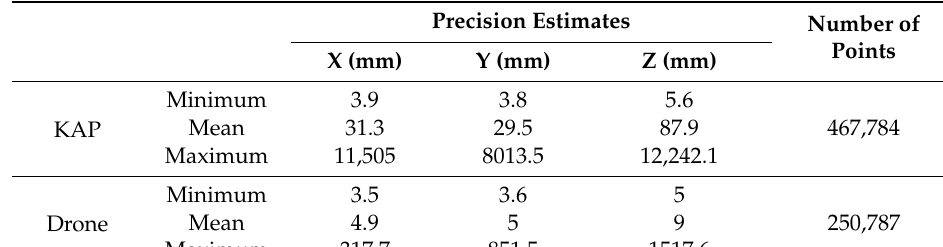
Table 2. M3C2-PM derived precision estimations for the points contained in the KAP versus drone subset area of interest (Figure S2).